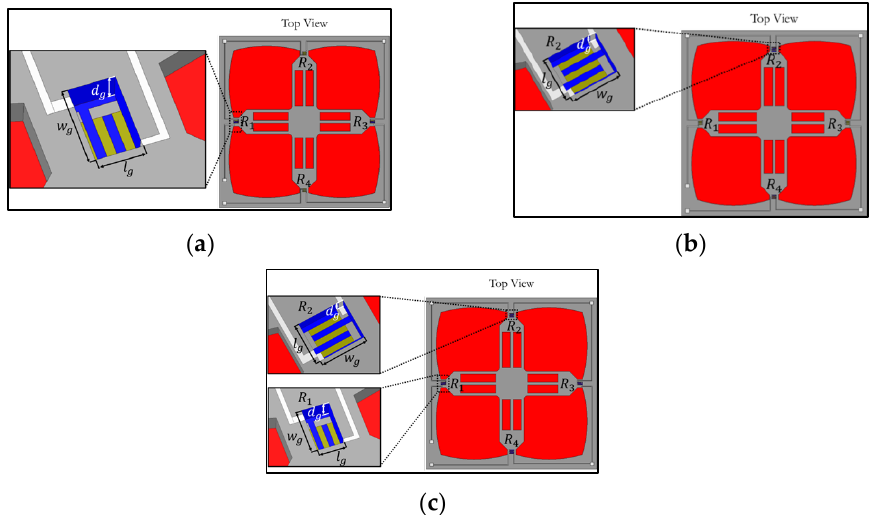
Figure 2. Local groove design 1: ( a ) grooves at longitudinal piezoresistors (𝐿𝐺1 − 𝐿0) , ( b ) grooves at transverse piezoresistors (𝐿𝐺1 − 0𝑇) and ( c ) grooves at locations of both longitudinal and transverse piezoresistors (𝐿𝐺1 − 𝐿𝑇 ). (Note: not to scale.)